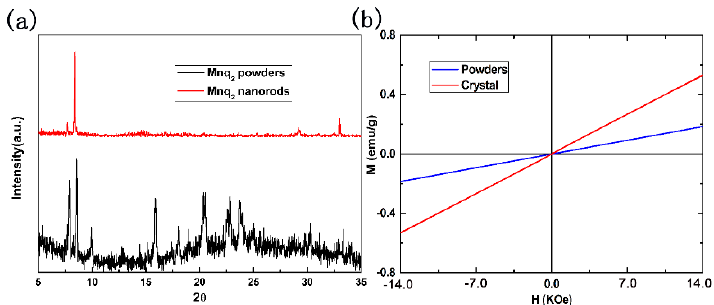
Figure 4. ( a ) XRD of Mnq 2 powders and nanorods. ( b ) The M-H curves of Mnq 2 powders and nanorods measured by alternating gradient magnetometer (AGM) at room temperature.